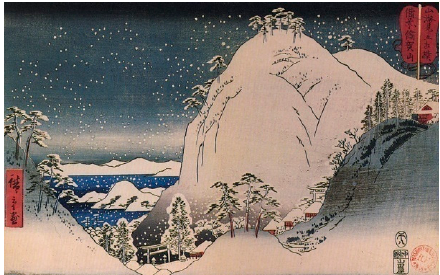
Figure 5. Utagawa Hiroshige (1797–1858), Shrines in Snowy Mountains ,